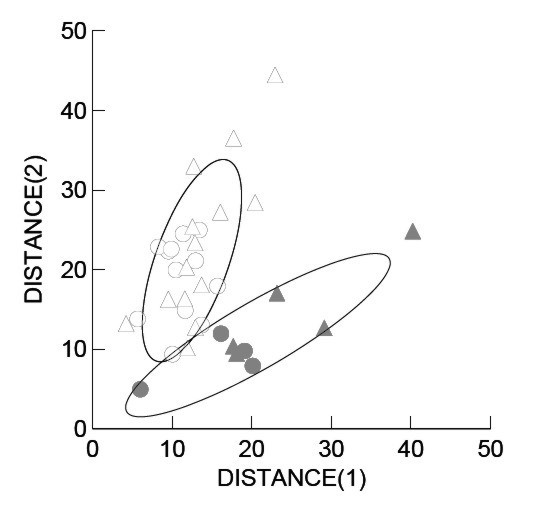
Mahalanobis distances of several foraging-related skull morphometric measurements with 95% confidence ellipses for female (circles) and male (triangles) adult Galápagos sea lions of either habitat (white = Centre, grey = West).